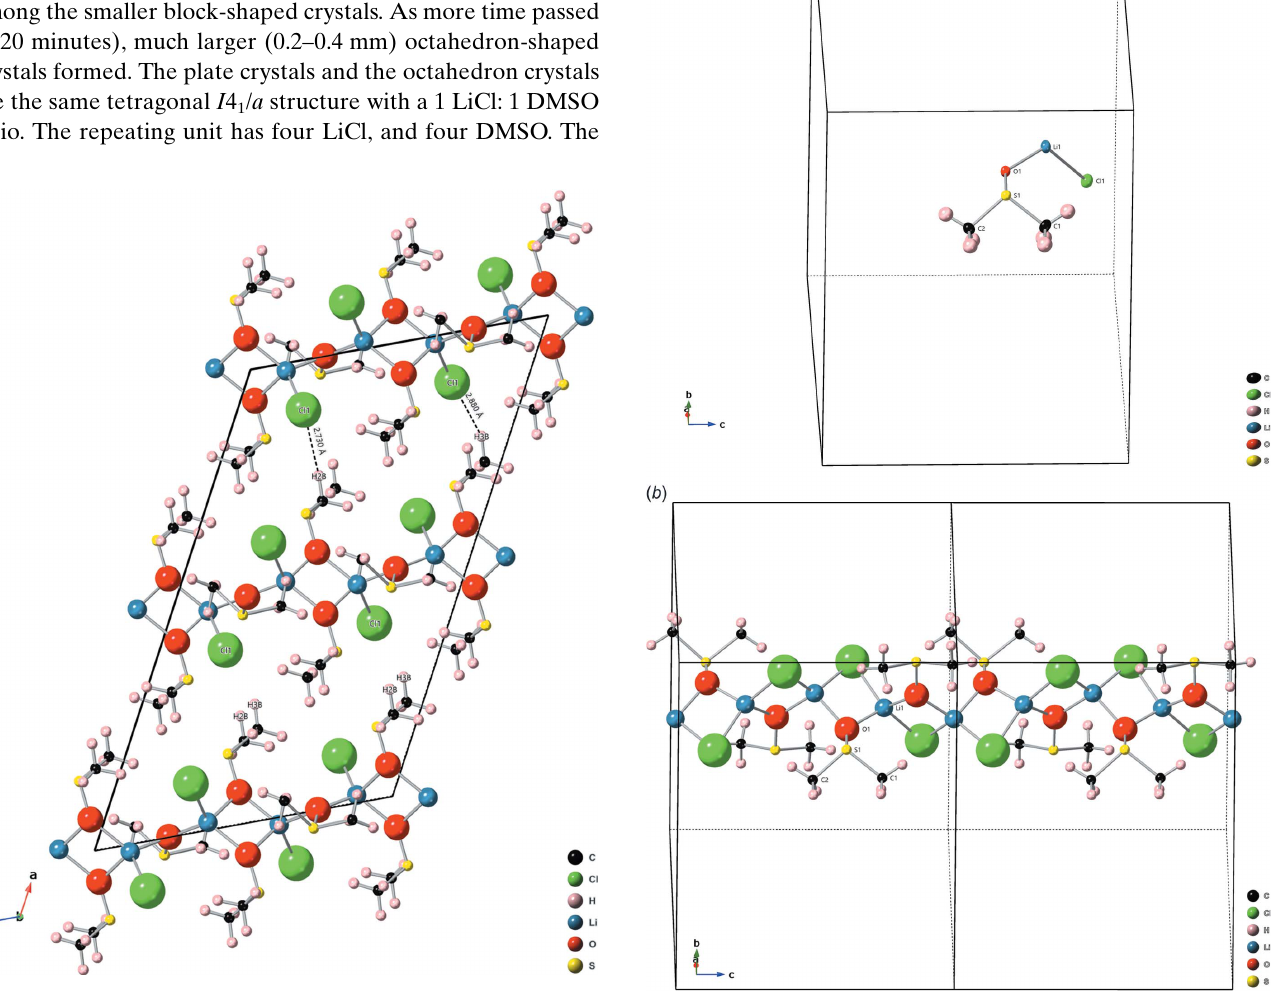
Figure 2 Monoclinic structure: packing diagram. The structure is held together by hydrogen bonding. The hydrogen bonds between Cl1 and H2 B as well as Cl1 and H3 B are shown.